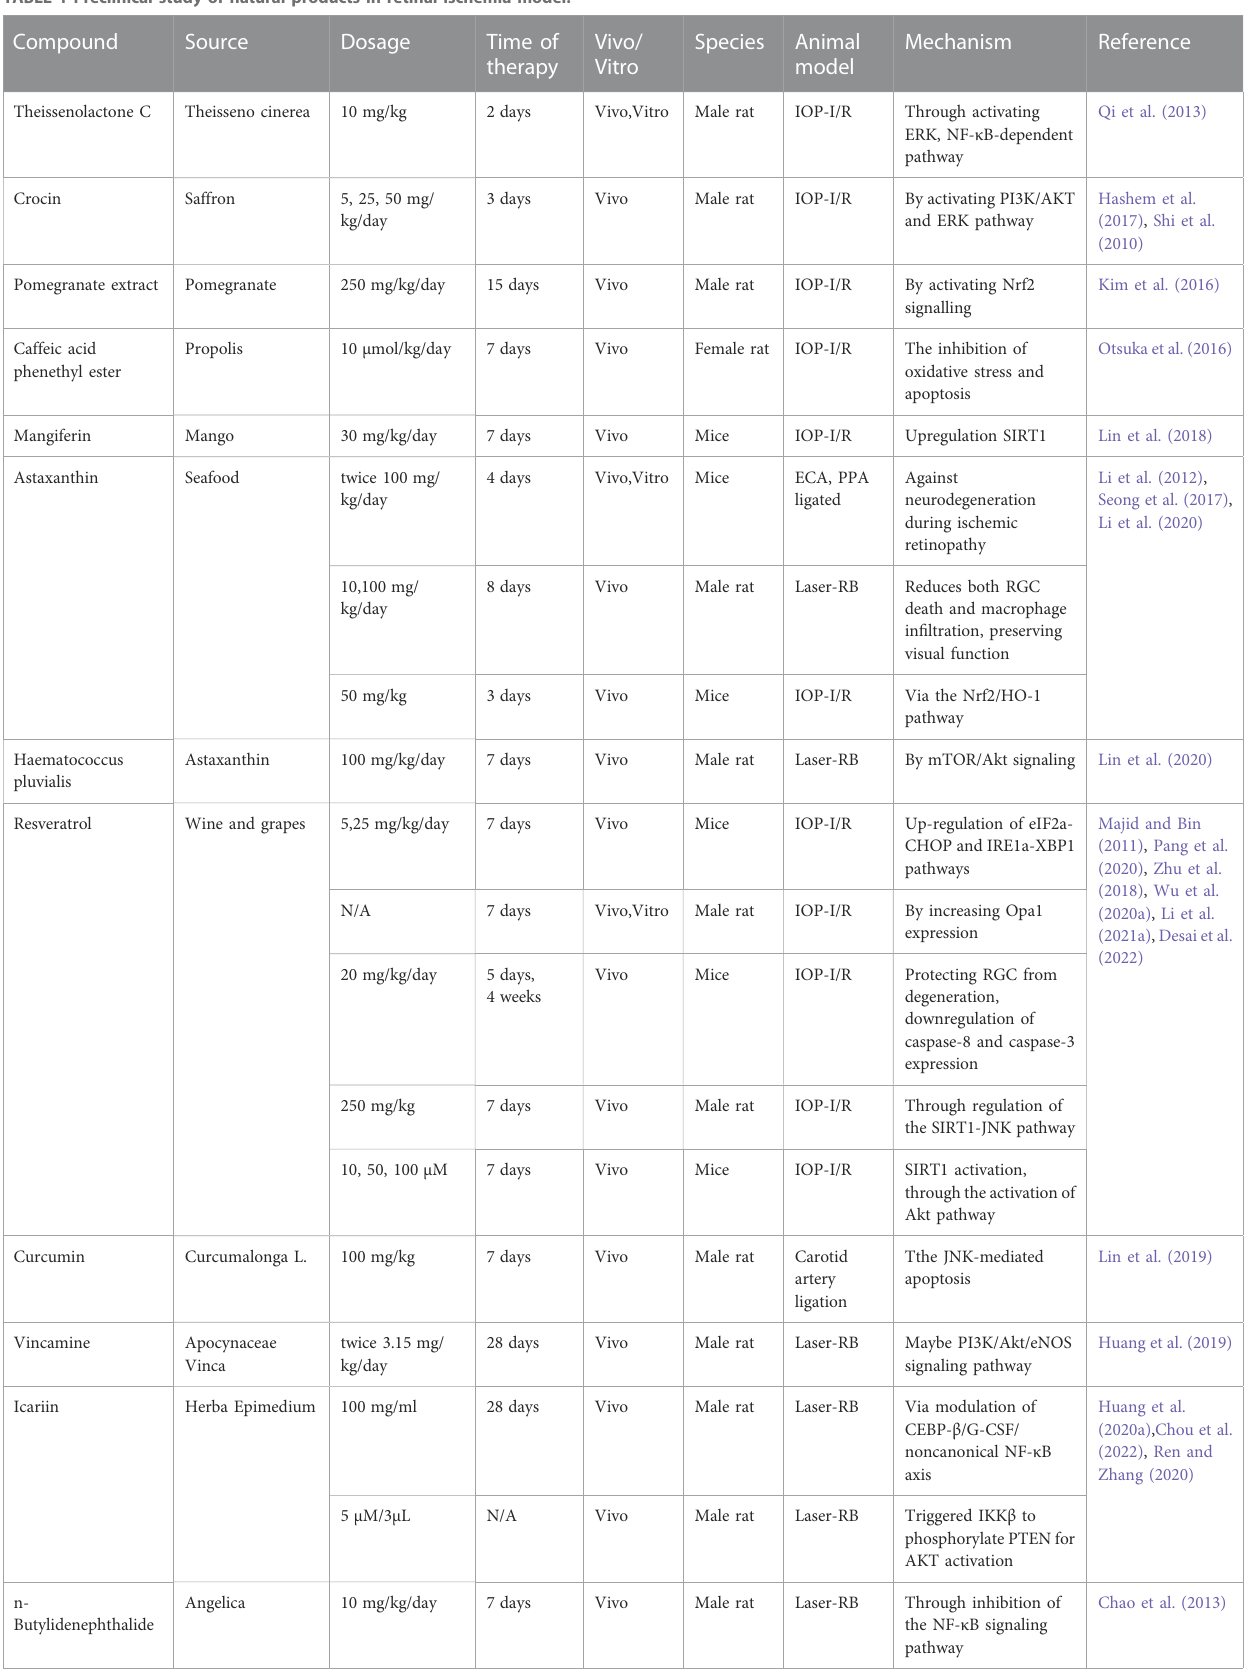
TABLE 1 Preclinical study of natural products in retinal ischemia